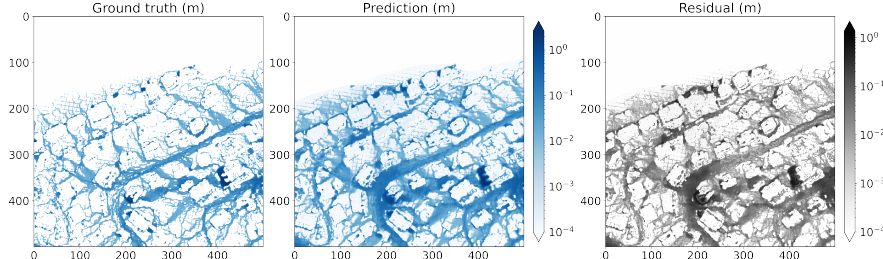
Figure A3. Ground truth maximum water depth and prediction for Lucerne catchment and rainfall event tr2_1 , with bounding box depicting the patch area shown in ( b